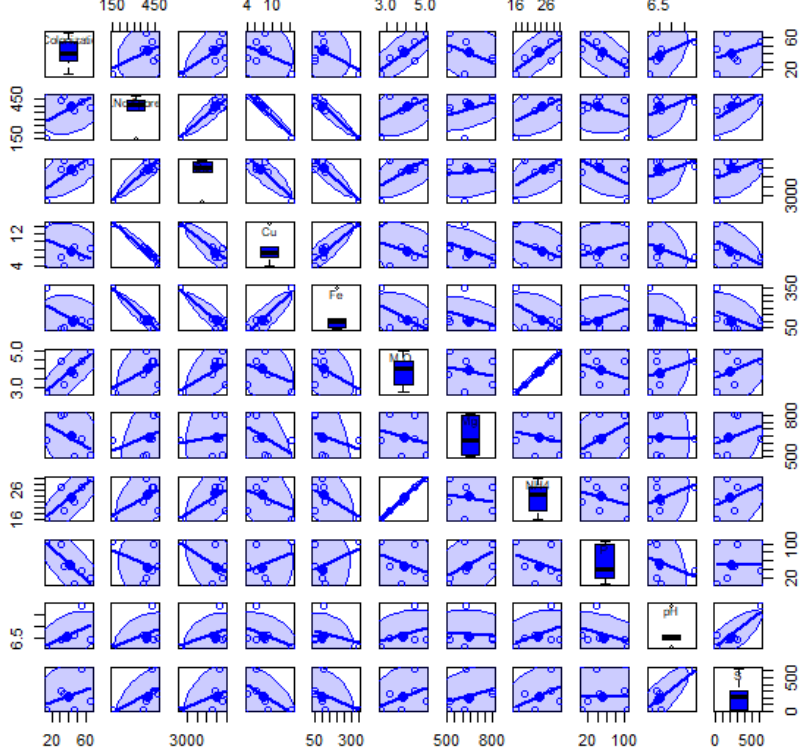
Figure A2. Scattering matrix, box and whiskers plot, concentration ellipsoid, and least squares line of physicochemical parameters versus colony and spore